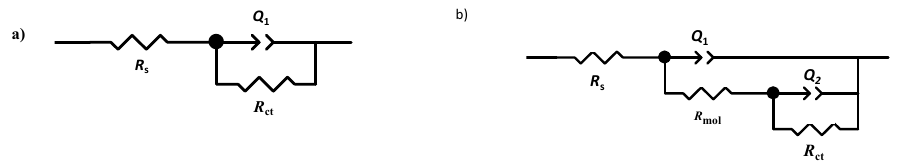
Figure 6. Equivalent electric circuits used in the system ( a ) without an inhibitor and ( b ) with inhib- itor.